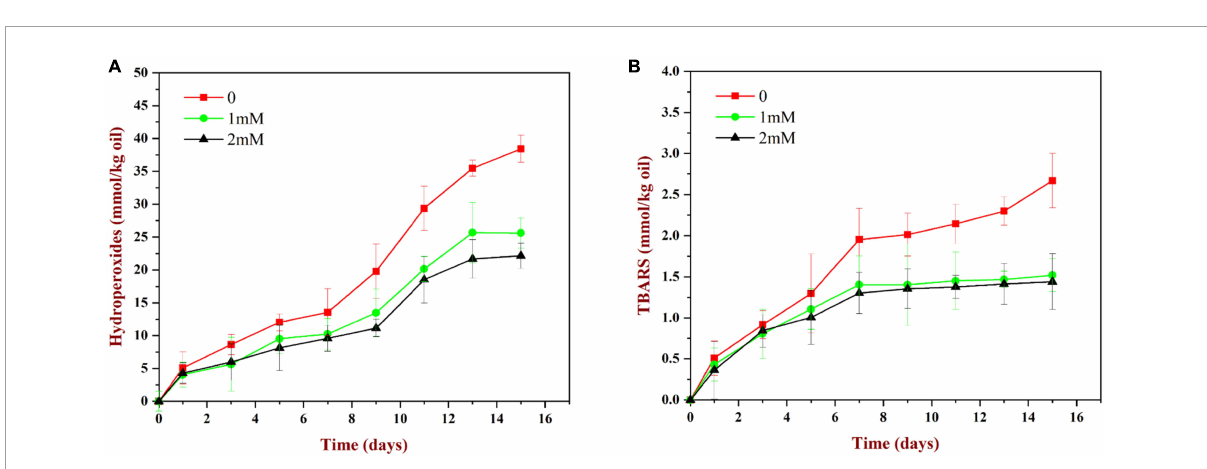
FIGURE11 Change in PV (A) and TBARS (B) values for WP based emulsion or WP-HES based emulsions during storage at 55 ◦ C for 15